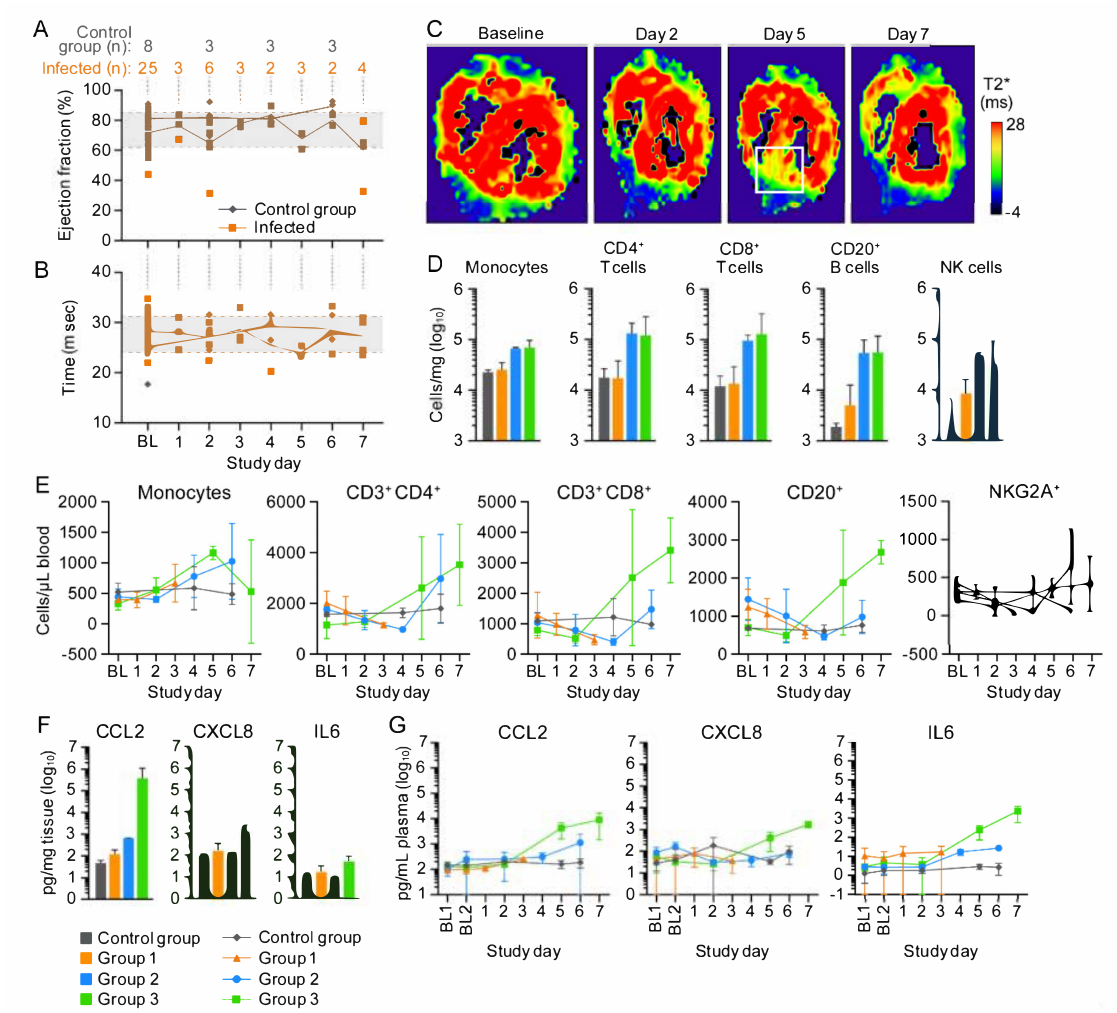
Figure 5. Myocardial hemorrhage and lymphohistiocytic inflammation in cowpox-virus-exposed macaques does not severely impact heart function. (Baseline values were averaged to establish a mean and one standard deviation left ventricular ejection fraction [LVEF] normal range.) ( A ) Changes in LVEF. ( B ) Myocardial hemorrhage as measured by T2*. ( C ) T2* maps of the most severely affected macaque. White square: area with increased T2*, indicating hemorrhage. ( D ) Peripheral blood mononuclear cells (PBMCs) infiltrated the heart tissue and peak at Day 6 post-exposure. ( E ) Circulating PBMC numbers increased by Day 4. Monocyte numbers declined in circulation by Day 7 but remained constant within the myocardium. ( F , G ) Heart tissue and plasma cytokine concentrations increased as disease progressed. Day 0 is not included on the graphs because no measurements were